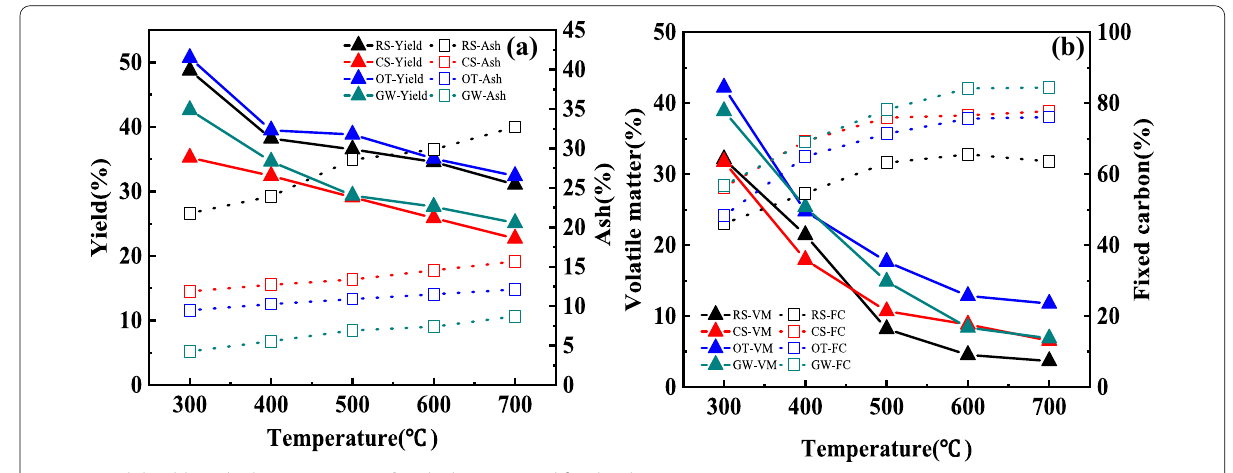
Fig. 2 a Solid yields and ash content image, b volatile matter and fixed carbon